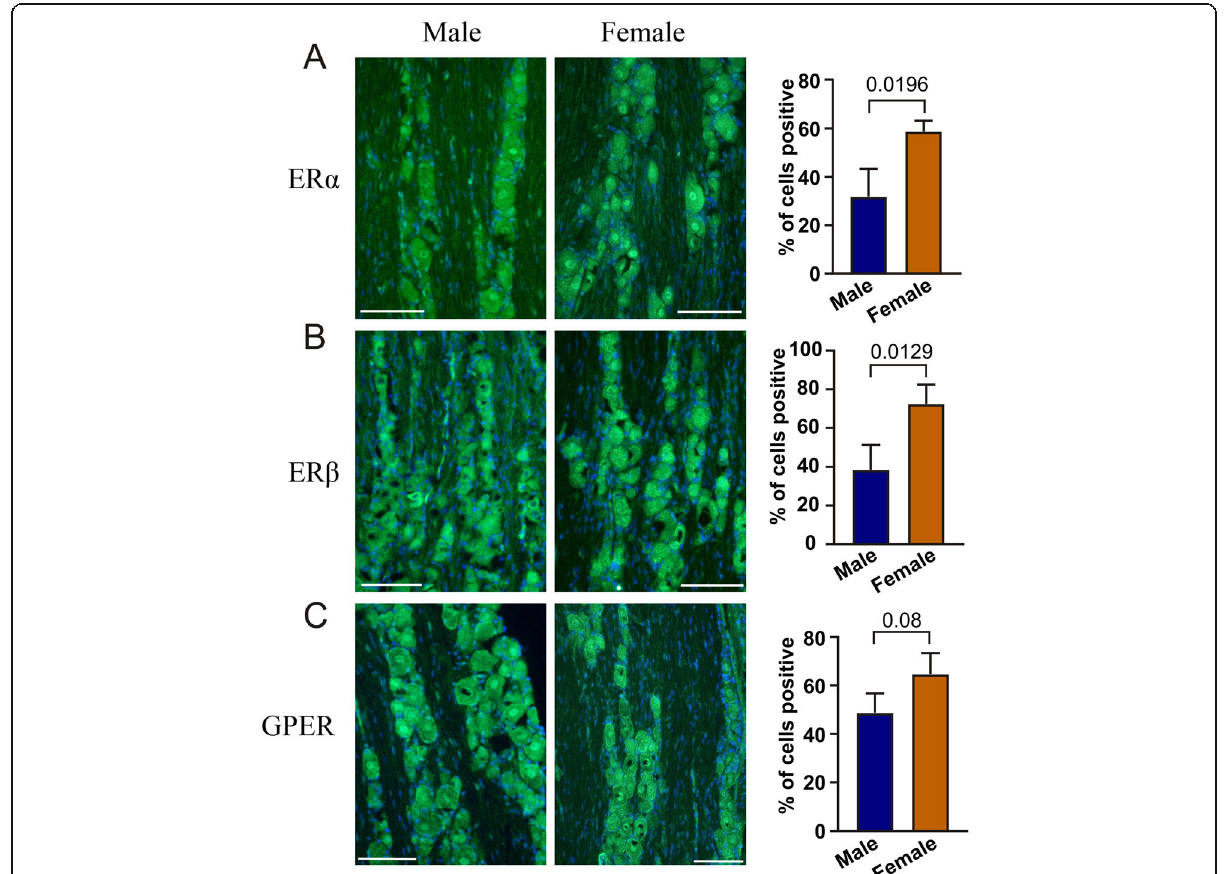
Fig. 10 Comparison of the expression of estrogen receptors in males and females. The numbers of immunoreactive neurons in male and female TG were calculated in more than 450 neurons. The data show the distribution in males and females of ER α , ER β and GPER. Data are shown as mean ± SEM or their individual data points with pairing, and with p values obtained with Student ’ s T-test being depicted in the